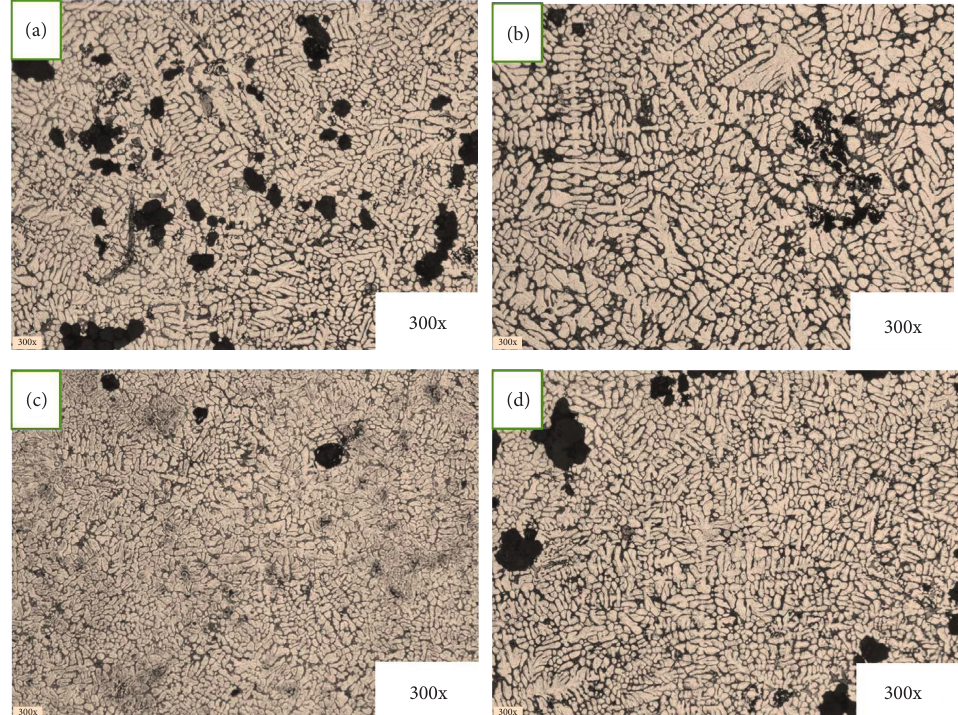
Figure 3: Optical morphological analysis of samples. (a) Mg alloy. (b) Coated Al